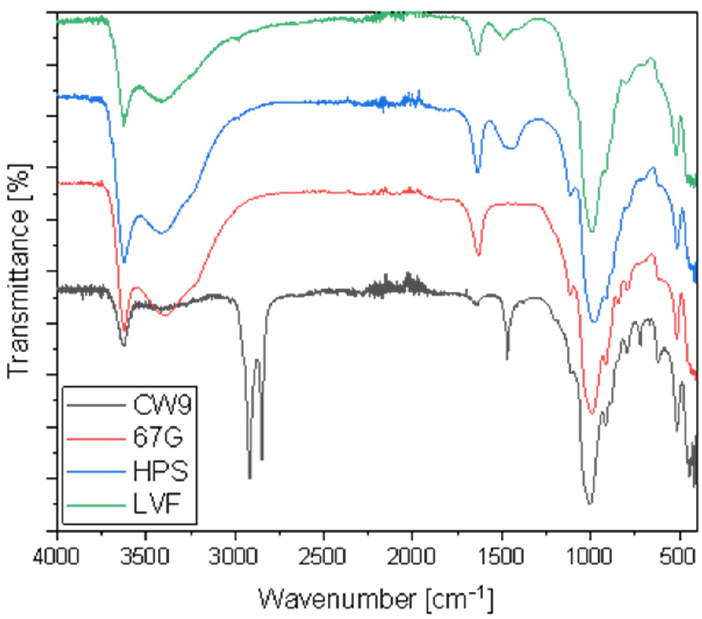
Figure 1. Fourier transform infrared (FTIR) spectra for different types of nanoclay.